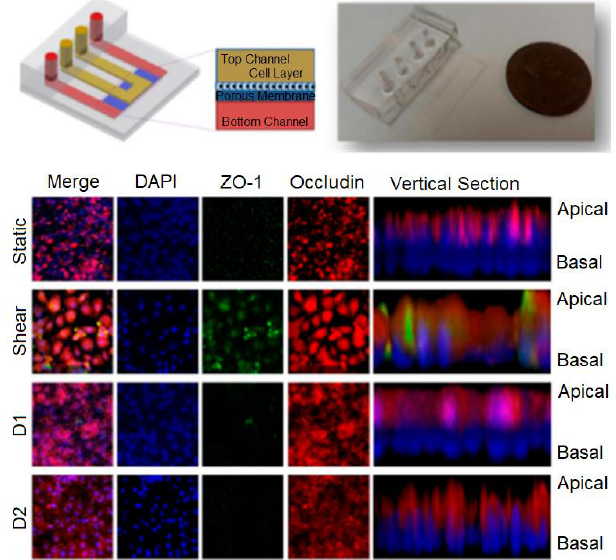
Figure 12. The kidney-on-a-chip was developed for monitoring nephrotoxicity [116]. ( A ) Schematic and actual image of the kidney-on-a-chip. ( B ) Biomarker expressions by the cells in the kidney-on-a-chip in different groups. Reproduced with permission from MDPI Copyright (2023).